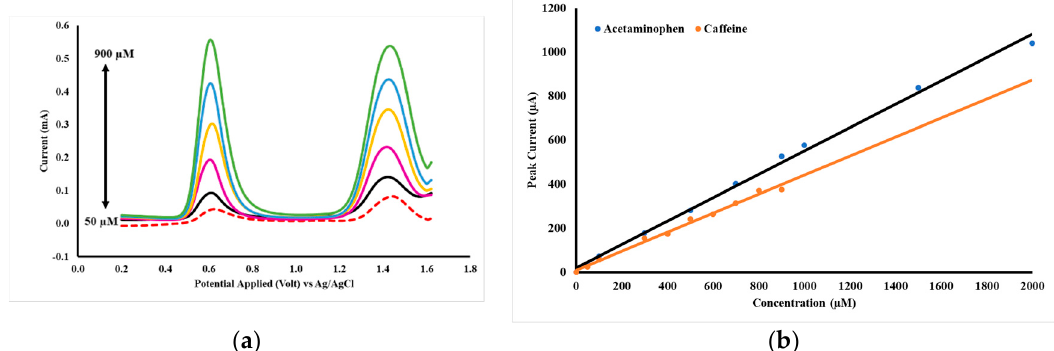
Figure 9. DPV acetaminophen and caffeine voltammograms at concentrations of 50–900 µM in PB pH 2 ( a ) and the curve of the relationship of acetaminophen and caffeine concentrations to peak currents ( b ), measured by a working electrode of GCE-M221-Fe 3 O 4 . Table 5. Analysis parameters of di ff erential pulse voltammetry (DPV) with acetaminophen and ca ff eine with GCE-M221-Fe 3 O 4 as a working